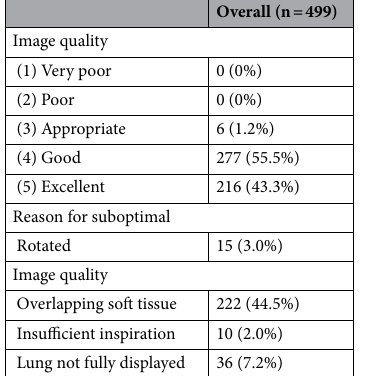
Table 1. Rating of the image quality and reasons for suboptimal image